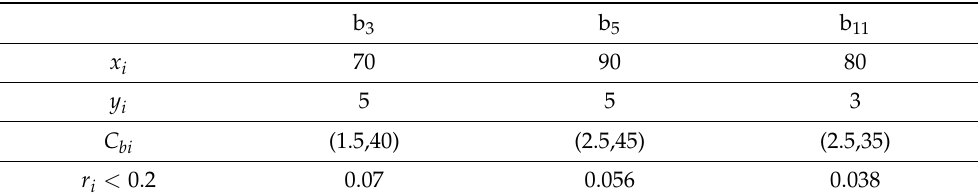
Table 4. Matrix of w k → r i < 0.2